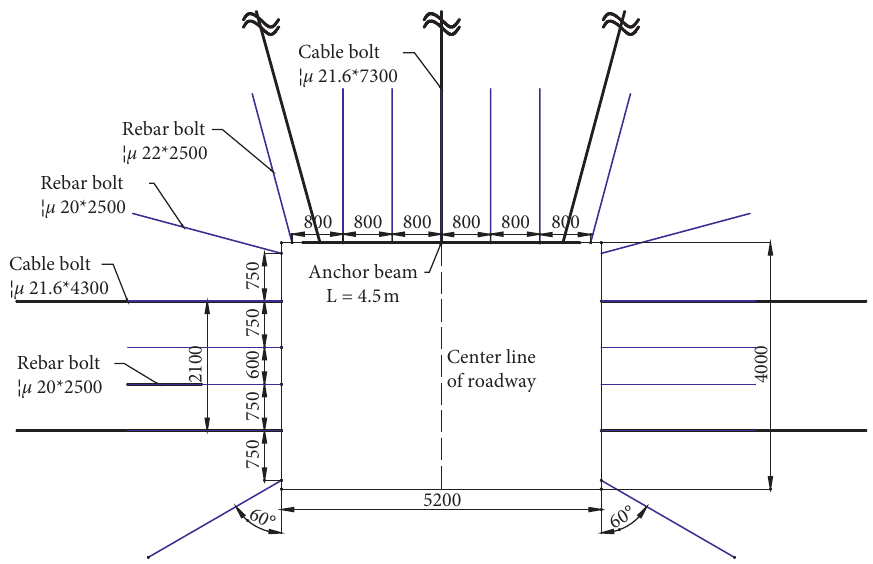
Figure 3: Support design of connection roadway of panel 1303.